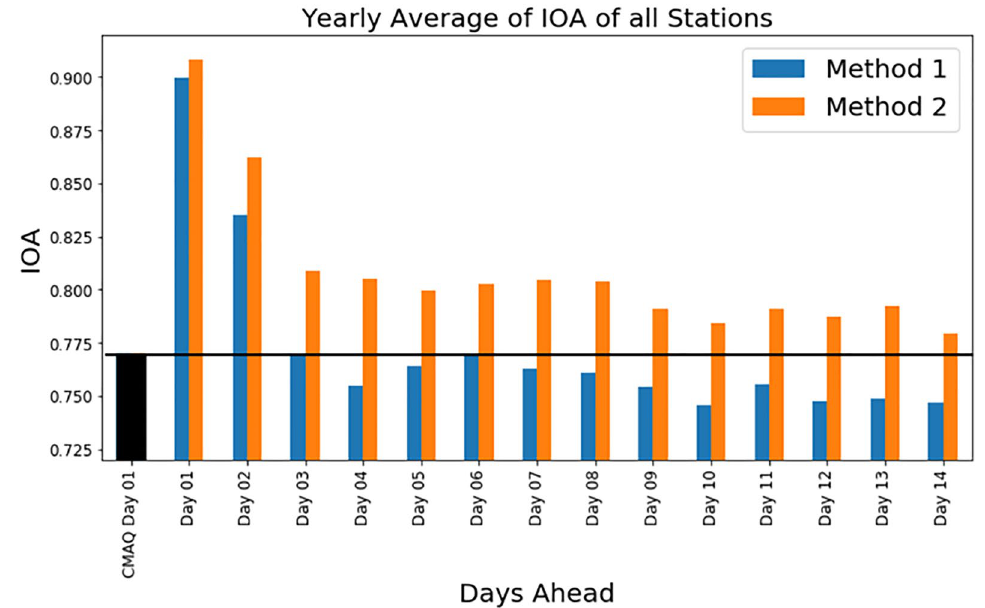
Figure 1. Comparison of Index of Agreement for two-advance prediction using Method 1 and 2. x-axis in the plot shows the days ahead, and the y-axis represents the index of agreement. The blue line represents the IOA of each day’s advance prediction using Method 1 (mean squared error as loss function). The orange line represents the IOA of each day advance prediction using Method 2 (Index of Agreement as loss